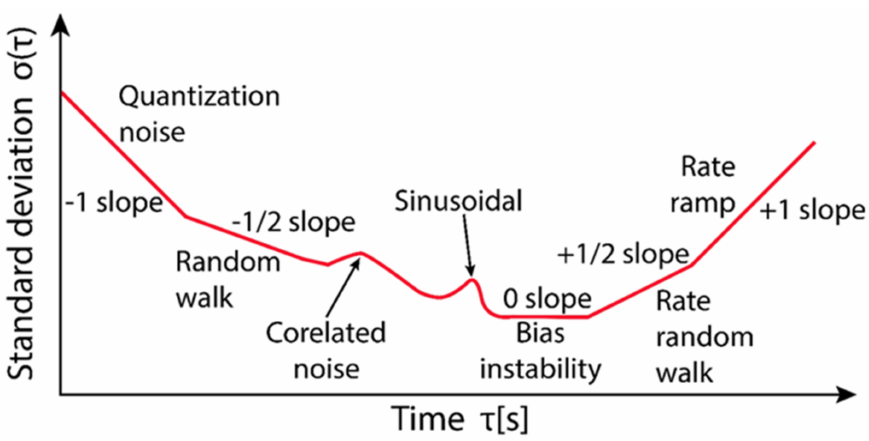
Figure 7. Identification of noises from the Allan variation